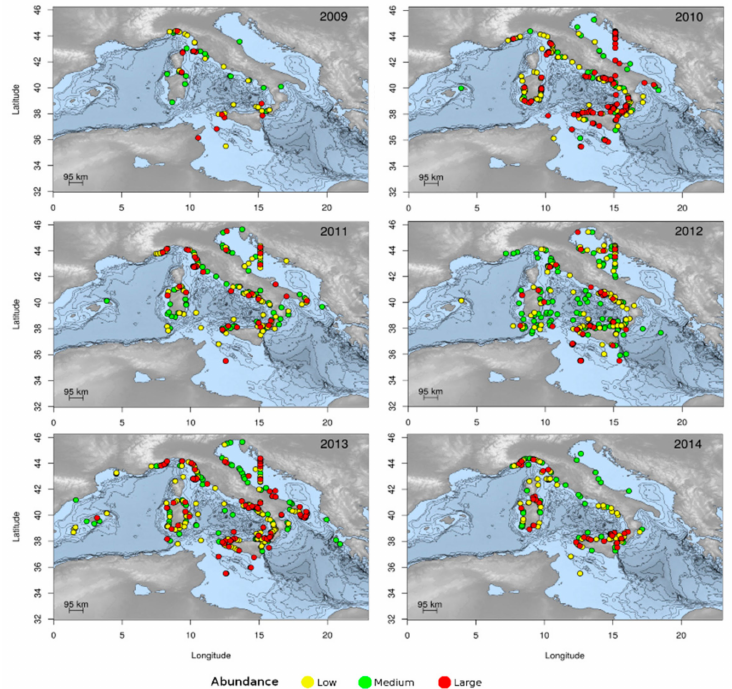
Figure 6. Spatial distribution of jellyfish reports from 2009 (upper-left panel) to 2014 (lower-right panel) for Pelagia noctiluca in Italy (* see Section 2.1—Materials and Methods). Abundance categories are shown as follows: category 1—“low” in yellow, category 2—“medium” in green, and category 3—“high” in red.